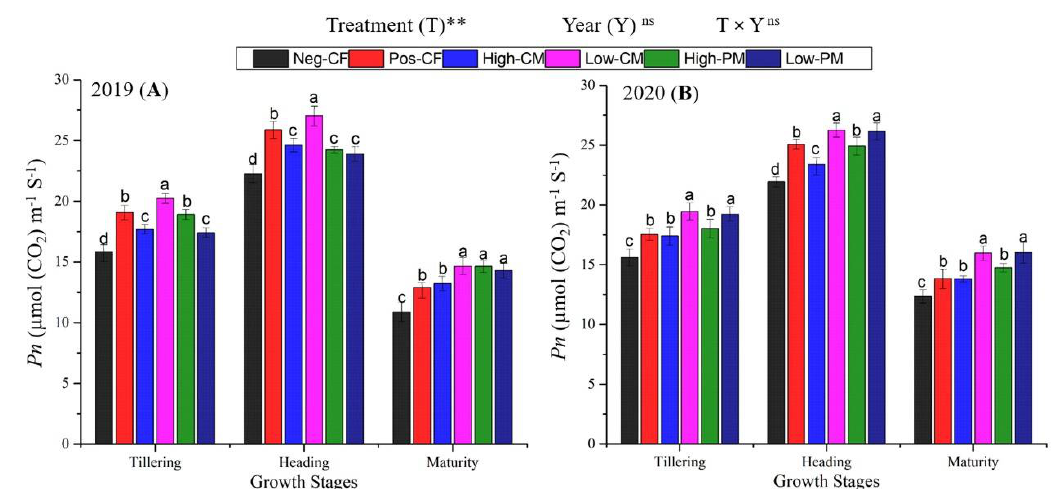
Figure 4. Changes in leaf net photosynthetic rate in the year 2019 ( A ) and 2020 ( B ) as affected by integrated manure and chemical N fertilizer application. Means sharing the same letter within a category are not significantly different according to Tukey’s HSD test at p < 0.05. ** = significant at 1%; ns = non-significant: Please see Figure 2 for the treatment combinations.